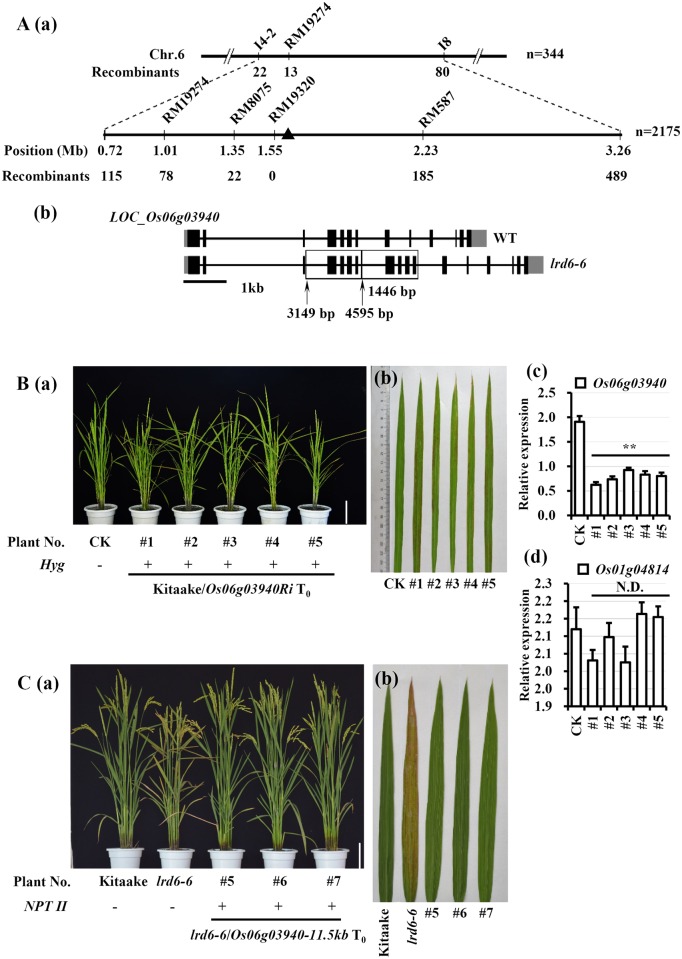
Positional cloning of Lrd6-6.(A) Fine mapping of the Lrd6-6 locus. The Lrd6-6 locus was delimited to a 93 kb interval between SSR markers RM8075 and RM587 on chromosome 6 (a). The molecular markers and the number of recombinants are shown. A structure variation (SV) was identified from the target gene Os06g03940 in the lrd6-6 mutant. The 1446 bp tandem repeat was found in the gene Os06g03940 which resulted in an additional insertion of 534 bp in the coding DNA of Os06g03940 in lrd6-6 (b). The SV mutation was detected by a whole genome resequencing approach and was confirmed by PCR-based sequencing. (B) Plants of RNAi-mediated silencing of Lrd6-6 exhibited spontaneous cell death phenotypes. The photographs of five representative transgenic T0 lines with cell death (#1–#5) and the control (CK) Kitaake are shown (a). Representative leaves from the plants indicated in (a) are shown in (b). Transcriptional expression levels of Os06g03940 and LOC_Os01g04814 which shares the highest identity with Os06g03940 in cDNA sequence in rice plants were respectively determined (c) and (d). PCR-based genotyping with the primer pair specific for the hygromycin (Hyg) gene was performed to determine whether the plants contained (represented by ‘+’) or lacked (represented by ‘-’) the transgene Os06g03940Ri. The relative expressions of the genes were normalized to the Ubq5 reference gene. The error bars represent the SDs of three biology repeats and the expression differences was determined by Student’s t-test (*, P < = 0.05; **, P < = 0.01; N.D., No significantly difference). (C) An 11.5 kb wild type genomic segment of Lrd6-6 completely rescued the cell death phenotype of the lrd6-6 mutant. Photograph of three independent representative T0 plants carrying the genomic DNA fragment of Lrd6-6 (Os06g03940-11.5kb) in the lrd6-6 mutant genetic background (a)–Kitaake and the lrd6-6 mutant are also included in the photograph. PCR-based genotyping of the Neomycin phosphotransferase II (NPT II) gene indicated that the plants contained (‘+’) or lacked (‘-’) the transgenic genome DNA fragment Os06g03940-11.5kb. Representative leaves from the plants indicated in (a) are shown in (b). Bars = 10 cm.